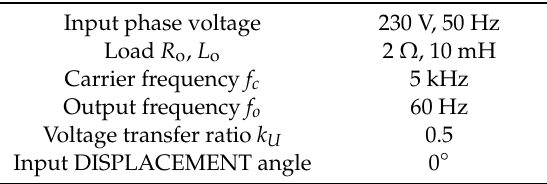
Table 4. The parameters used in